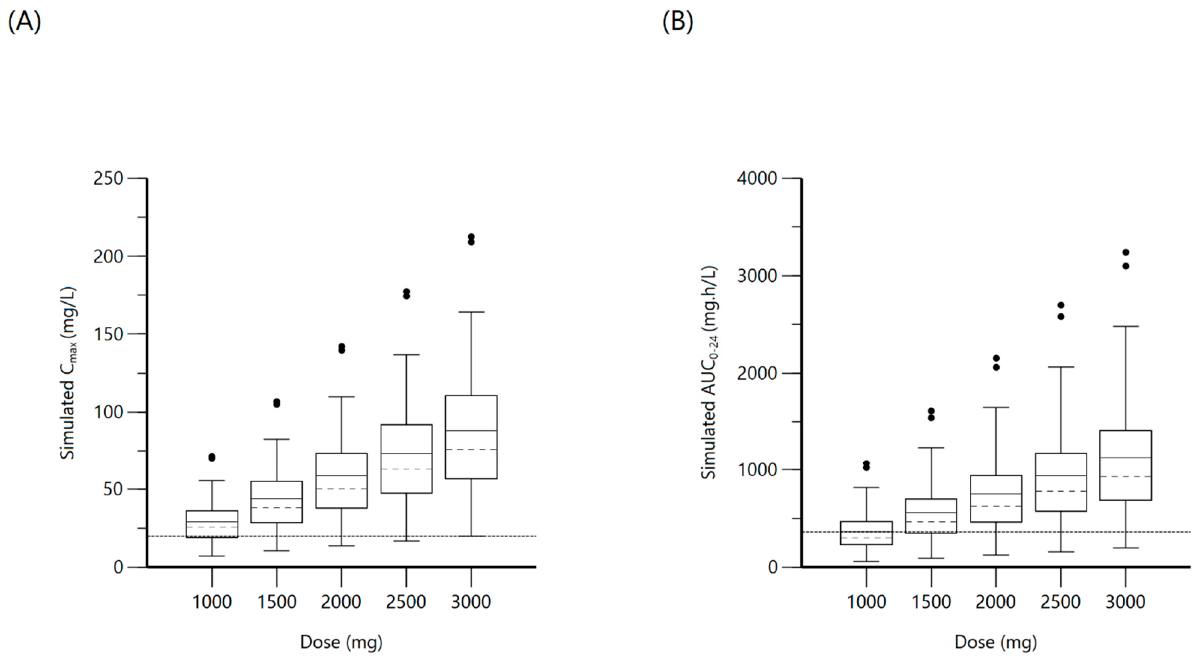
Figure 6. Plot ( A ) represents simulated pyrazinamide C max at various doses with the dashed line indicating the minimum threshold of 20 mg/L. Plot ( B ) represents simulated pyrazinamide AUC 0–24 at various doses with the dashed line indicating the minimum threshold of 363 mg.h/L.